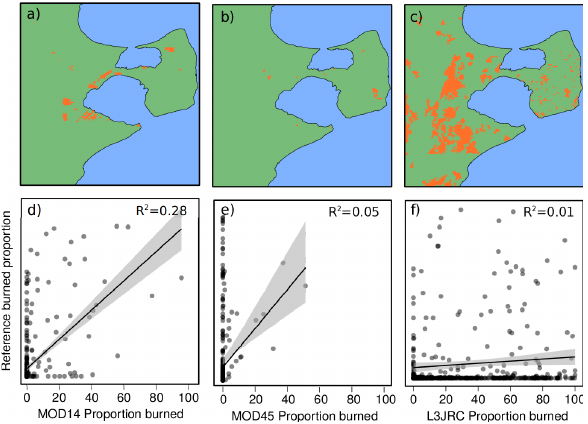
Figure 5: Spatial distribution of burned areas detected by a) MOD14, b) MOD45, c) MOD 45; and scatter plot of the proportions of 5 × 5 km cells labeled as burned by the c) MOD14, d) MOD45, and e) L3JRC plotted against the proportion labeled as burned by reference data. The regression lines are plotted as a solid black line, and smoothed 0.95 confidence interval in